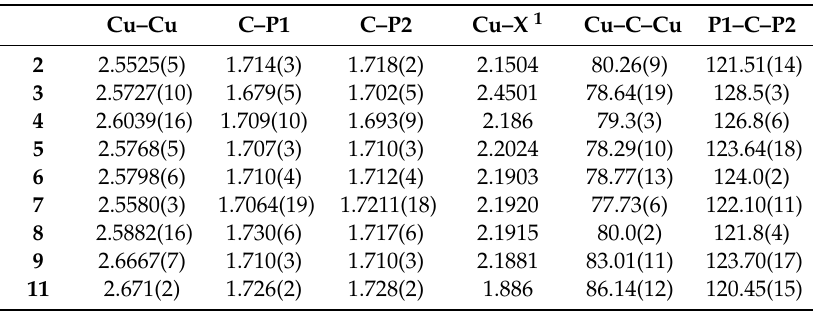
Figure 1. XRD molecular structures of [(CuCl) 2 (CDP(Py) 2 )] ( 2 ), [Cu 2 (PPh 3 )(CDP(Py) 2 )](PF 6 ) 2 ( 4 ), [Cu 2 (DPEPhos)(CDP(Py) 2 )](PF 6 ) 2 ( 6 ), [Cu 2 (XantPhos)(CDP(Py) 2 )](PF 6 ) 2 ( 7 ), [(CuS(C 6 F 5 )) 2 (CDP(Py) 2 )] ( 9 ), and [(CuCarb) 2 (CDP(Py) 2 )] ( 11 ). Hydrogen atoms and solvent molecules have been omitted for clarity; thermal ellipsoids are given at 50% probability. For 4 , 6 , and 7 , the counter anions [PF 6 ] − are omitted for clarity. The labeling of 2 is identical for all species. For details and further XRD molecular structures of 3 , 5 , and 8 , see the Supplementary Materials. Table 1. Selected bond distances [Å] and angles [ ◦ ] for 2 – 9 and 11